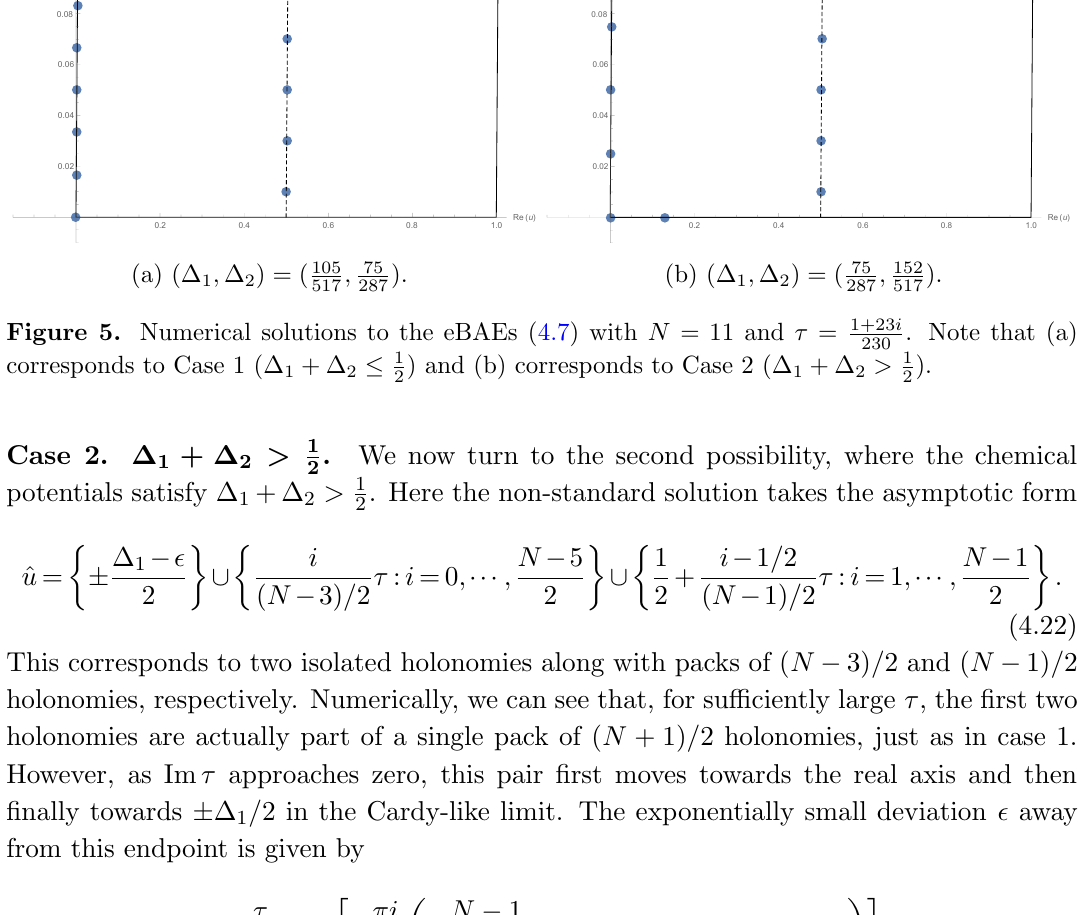
Figure 5. Numerical solutions to the eBAEs (4.7) with N = 11 and (cid:28) = 1+23 i corresponds to Case 1 ((cid:1) 1 + (cid:1) 2 (cid:20) 1